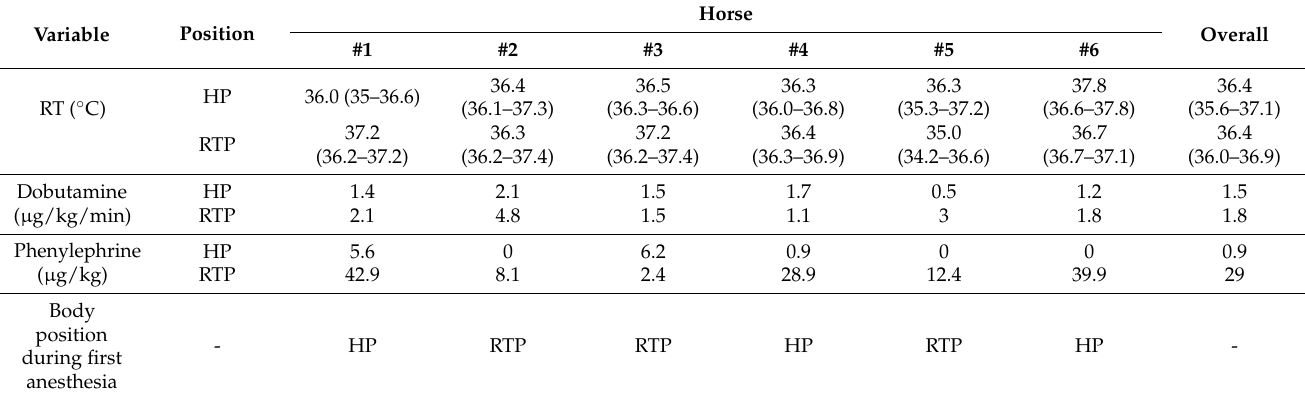
Figure 2. Individual changes in arterial median oxygen tension (PaO 2 ; panel a ), total respiratory system compliance (C tot ; panel b ), and Spearman correlation between changes in PaO 2 and C tot (panel c ) during 2 h of isoflurane anesthesia in 6 dorsally recumbent, mechanically ventilated horses positioned either horizontally (HP) or in a 15 ◦ reverse Trendelenburg position (RTP). Measurements were obtained every 30 min during the 2 h of anesthesia in each designated position. Individual horses are identified with a unique symbol: open square (horse #1), filled square (#2), open circle (#3), filled circle (#4), open triangle (#5), and filled triangle (#6). Horse #5 (open triangle) was considered an outlier and excluded from statistical comparison. Median PaO 2 during RTP (502 mmHg) and HP (437 mmHg) were significantly different ( p = 0.03; Wilcoxon matched-pair sign rank test; n = 5). Median C tot during HP (0.69 mL/cmH 2 O/kg) and RTP (0.75 mL/cmH 2 O/kg) were not significantly different (P=0.62; Wilcoxon matched–pair sign–rank test; n = 5). Spearman correlation between changes (RTP minus HP) in PaO 2 and C tot was 0.64 with p = 0.09 ( n = 6). Table 3. Median (range) values of rectal temperature (RT) and doses of dobutamine and phenyle- phrine in isoflurane-anesthetized horses ( n = 6) positioned either horizontally (HP) or in 15 ◦ reverse Trendelenburg position (RTP). Body position (HP or RTP) during the first anesthetic event is also quirement of dobutamine and phenylephrine were not compared statistically between groups. The heart rates and mean arterial pressures for individual horses are shown in